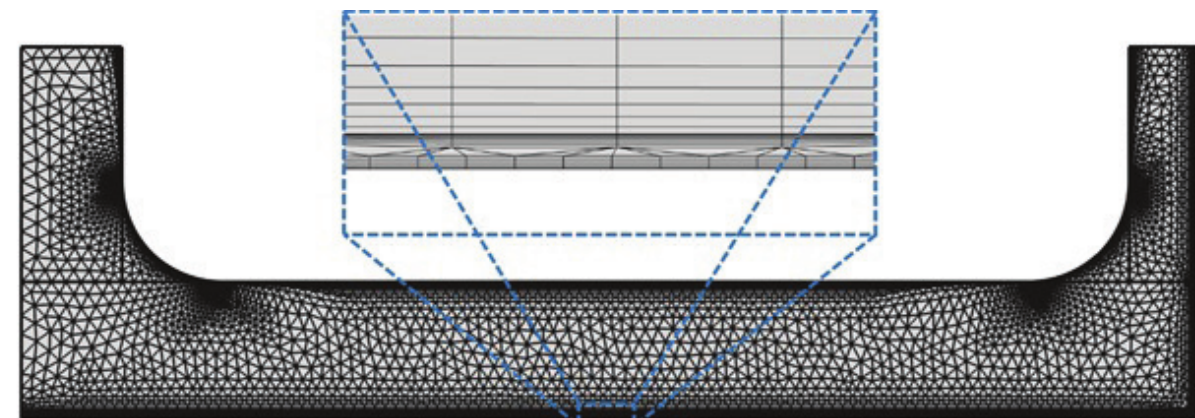
Fig. 3 – Mesh used in membrane